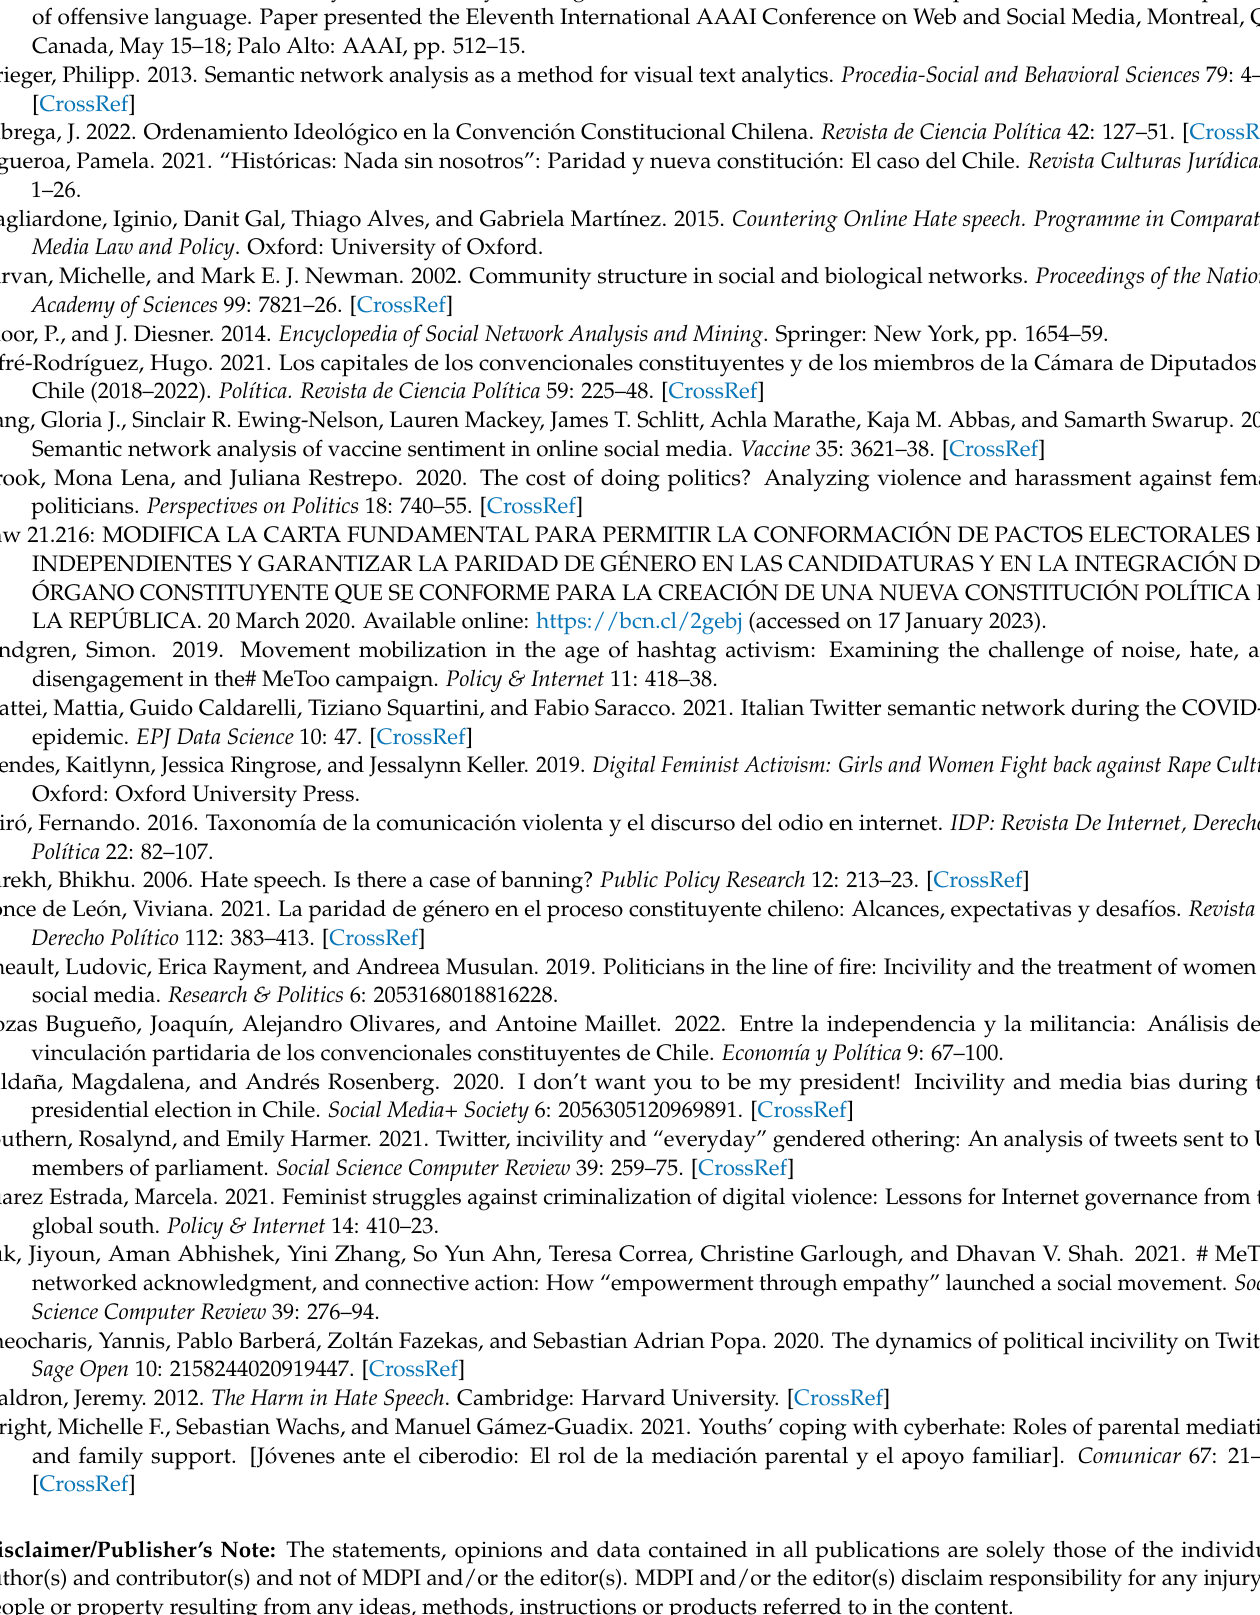
Figueroa, Pamela. 2021. “Hist ó ricas: Nada sin nosotros”: Paridad y nueva constituci ó n: El caso del Chile. Revista Culturas Jur í dicas